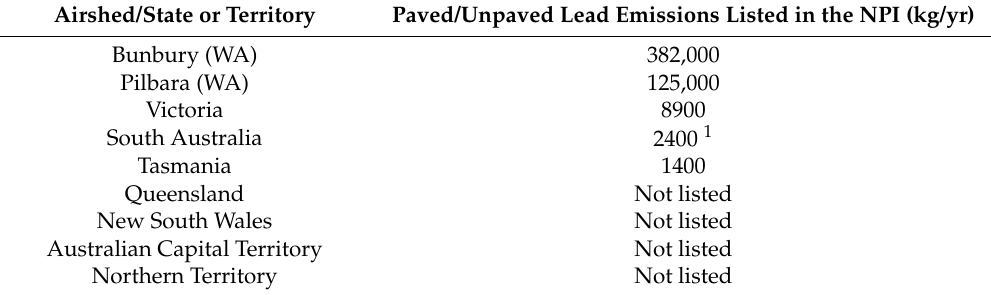
Table 1. Airborne lead emissions from Paved and Unpaved roads combined for the disaggregated airsheds of Bunbury and Pilbara, WA and all States and Territories for 2013–2014 (rounded to the nearest thousand)